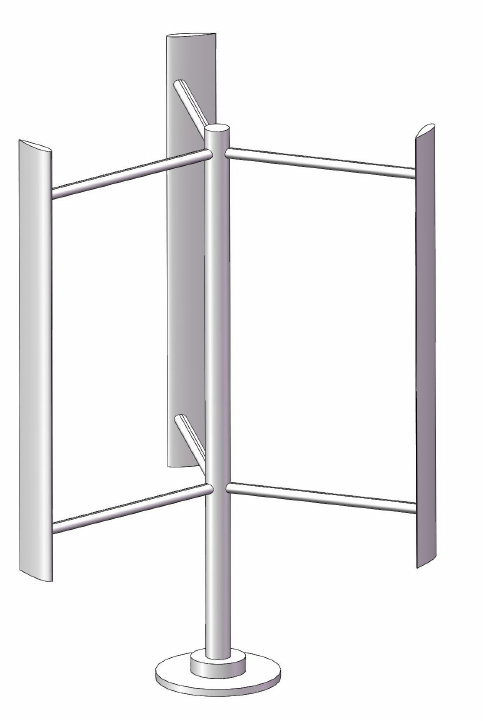
Figure 4. Model of symmetrical airfoil J-blade offshore wind